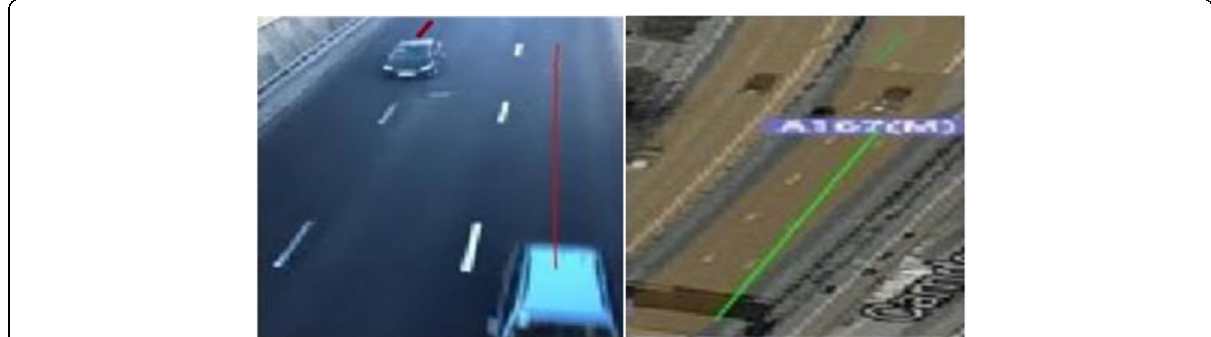
Fig. 16 a Trajectory of vehicle 4. b Mapping trajectory onto a Google